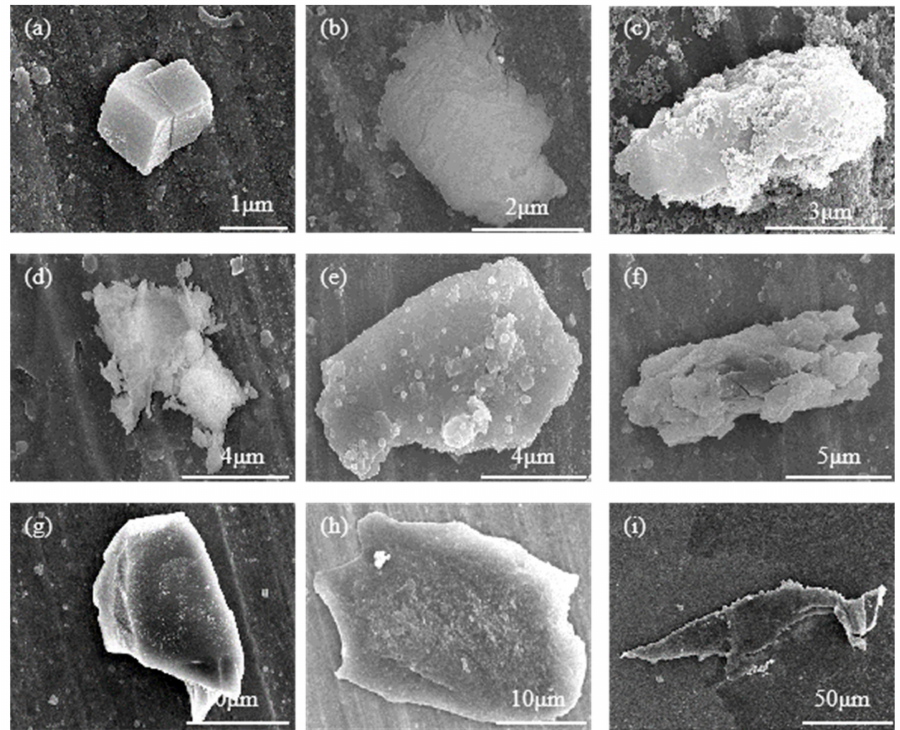
Figure 4. SEM images of single particulate matter in different particle size ranges: 1~3 µ m SEM image ( a – c ); 4~5 µ m SEM image ( d – f ); 10~25 µ m SEM image ( g – h ); >25 µ m SEM image ( i